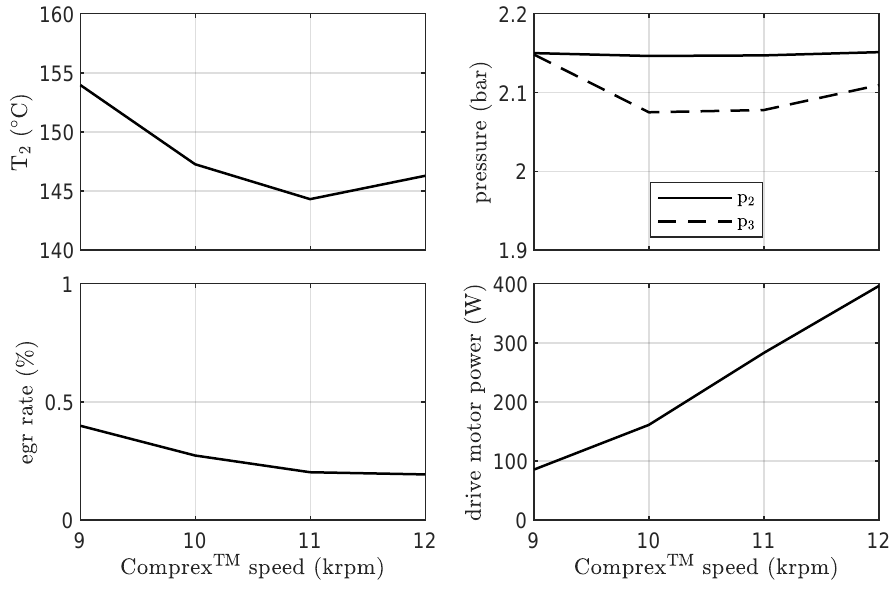
Figure 5. Variation of the rotor speed at 2250 rpm and 400 Nm, operation with both